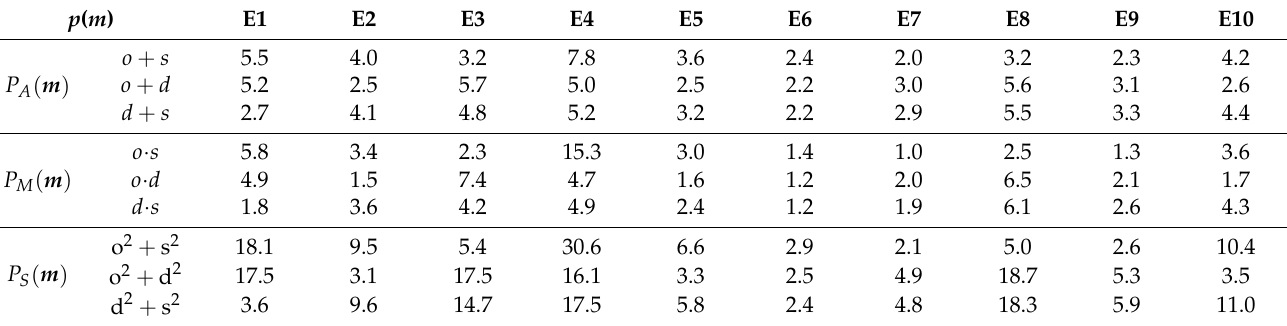
Table 5. Local weights of SIGs.